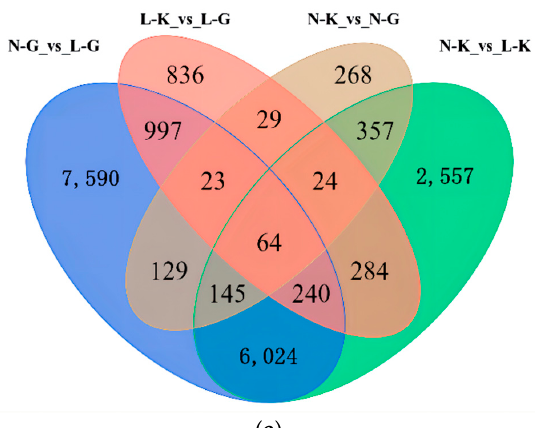
Figure 4. Note: in ( a ), PCA diagram, PC1 represents the first principal component, PC2 represents the second principal component, and the percentage represents the interpretation rate of the principal component to the data set; each point in the figure represents a sample, and the samples of the same group are represented by the same color. In the ( b ), Correlation heat map, r 2 is to 1, the stronger the correlation between the two repeated samples is. Curves in different colors in ( c ) represent different samples. Expression density distribution. The abscissa of points on the curve represents the log value of the FPKM of the corresponding sample, and the ordinate of points represents the probability density. ( d ) represents the number of differentially down-regulated genes in different combinations. Differential gene histogram. In the Venn diagram ( e ), Venn diagram, the non-overlapping region represents the unique differential genes of the differential group and the overlapping region represents the common differential genes of several overlapping differential